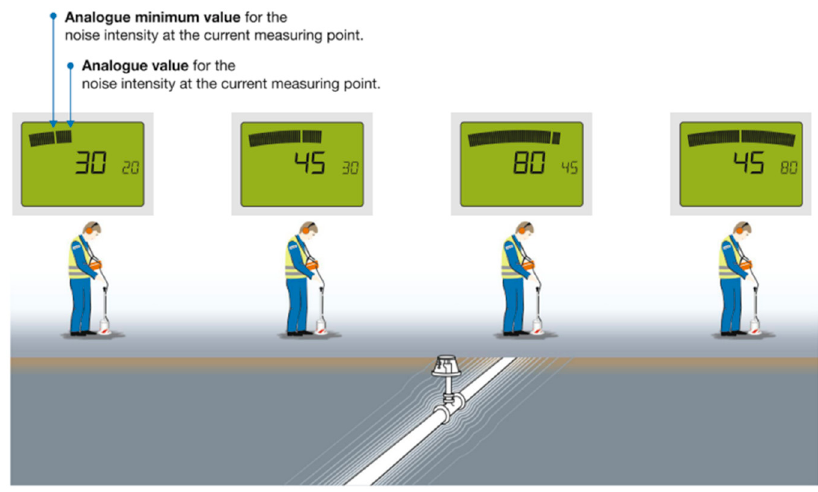
Figure 18. Buried pipelines localization using the System Combiphon [116].